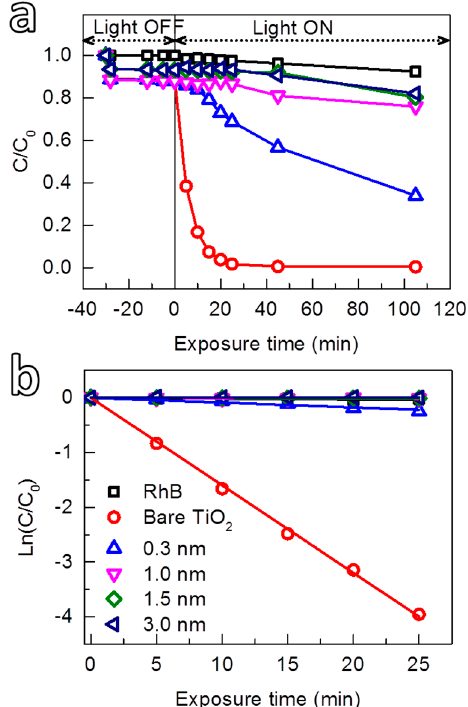
Figure 6. ( a ) Photodegradation of RhB solution using anatase TiO 2 coated with Al 2 O 3 films with different thicknesses as a function of exposure time, and ( b ) the corresponding kinetic reaction plots.